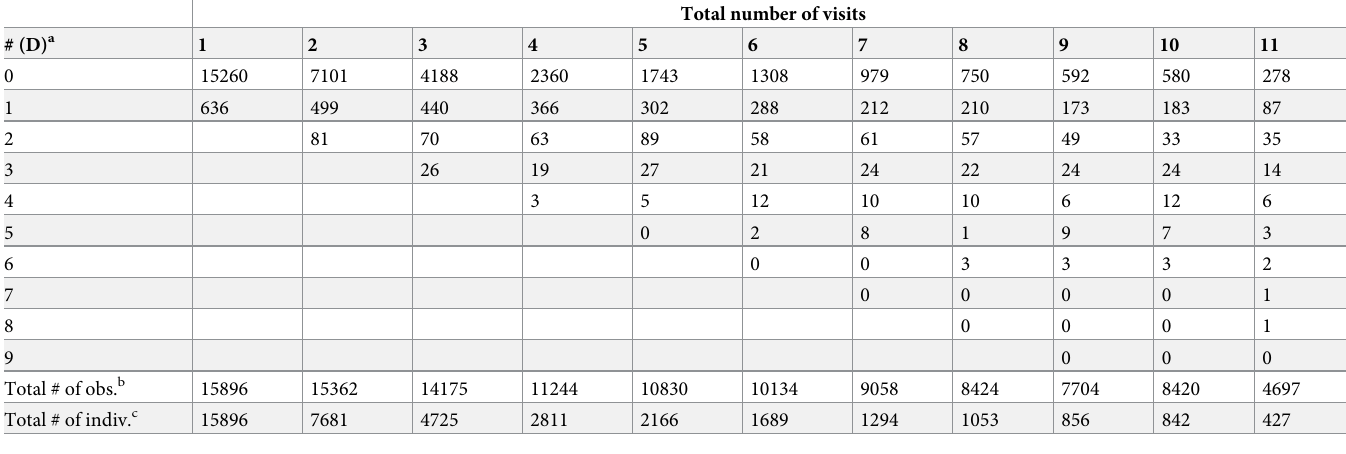
Table 2. Number of EIA indeterminate results by total number of visits per participant.